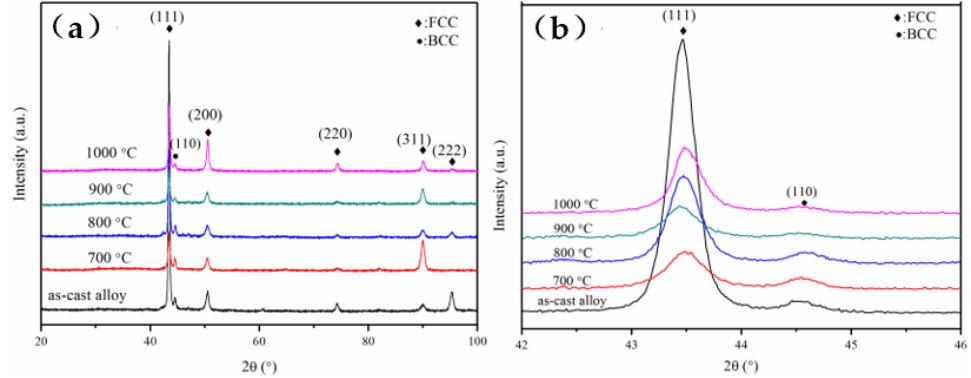
Figure 2. XRD patterns of the FeCrMnNi alloys ( a ) XRD patterns of FeCrMnNi alloys and ( b ) XRD patterns of FeCrMnNi alloys.